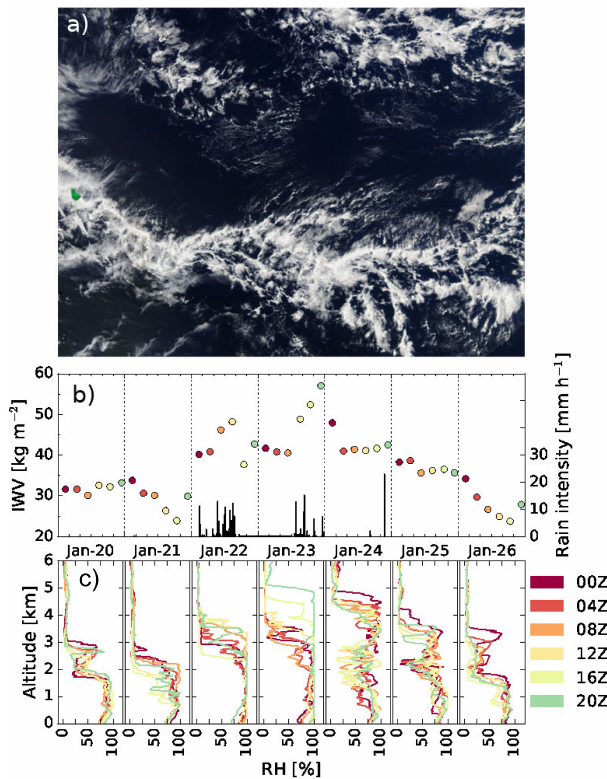
Figure 10. Fish cloud pattern passing Barbados between 22– 24 January 2020. (a) MODIS-Aqua scene from 22 January. The image covers 9–18 ◦ N, 48–60 ◦ W, with Barbados shown in artifi- cial green. (c) Temporal evolution of relative humidity (b) and in- tegrated water vapor (IWV; color-coded) as measured by the BCO soundings on 20–26 January. Profiles and calculated IWV values are color-coded according to the nearest hour of the sounding reach- ing 100hPa. Panel (b) also shows a 1-minute running mean of rain intensity recorded at BCO